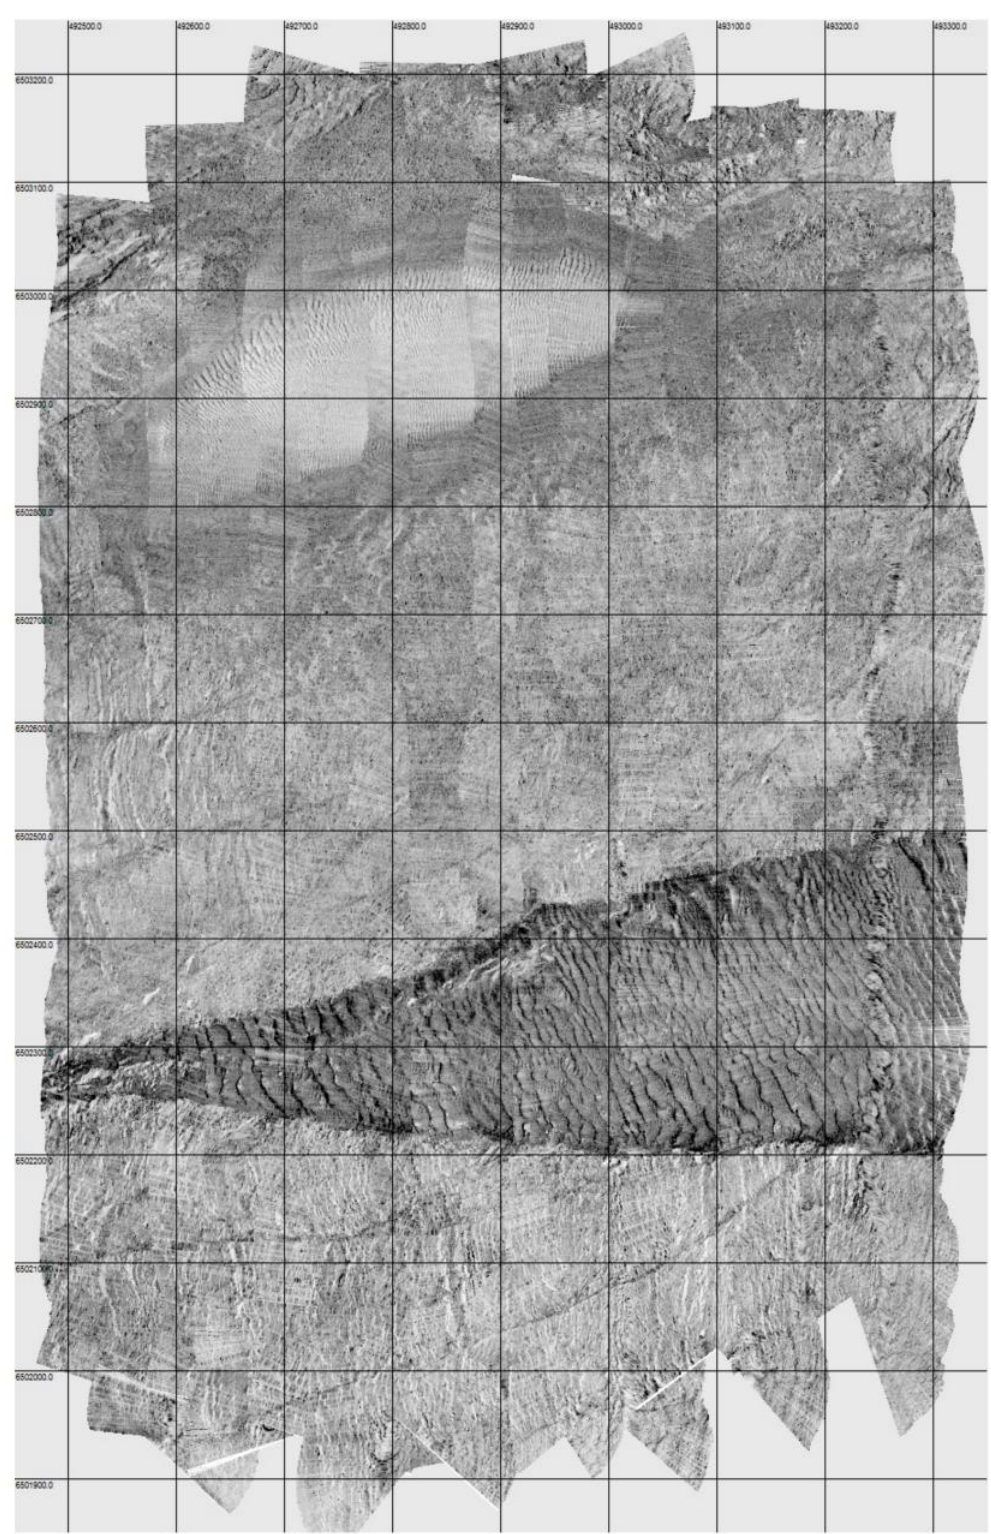
Figure 6. Inner Sound, Pentland Firth. A montage of 15 swaths of the mid-frequency data (256 kHz) shown in greyscale overlain from west to east (ensonification to the west). The grid lines are spaced at 100 metre